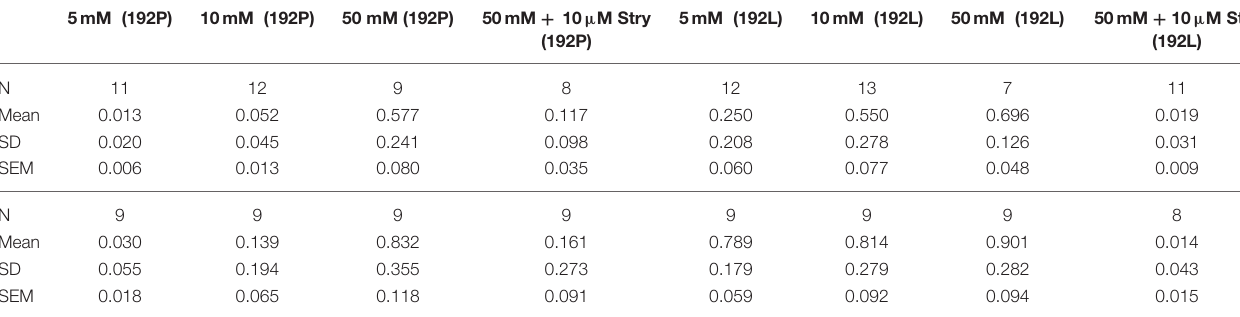
TABLE 2 | Whole cell patch clamp recording of transfected HEK293T